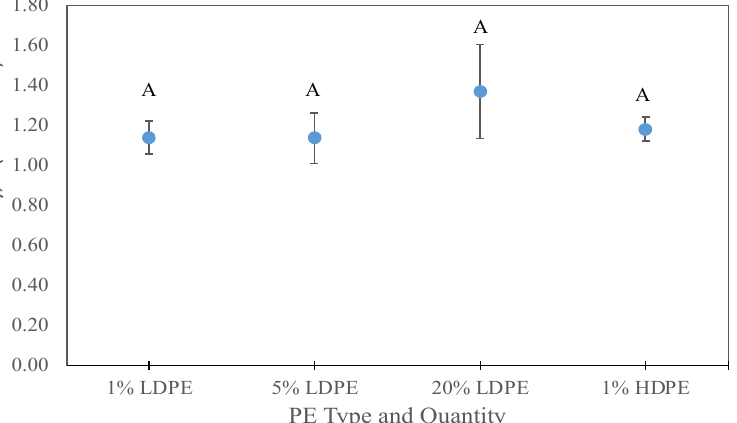
Figure 6. Preform permeability by PE type (PE types with the same letter indicate that their means were not statistically significant).